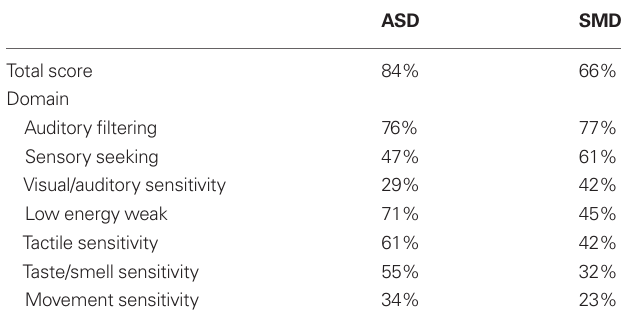
Table 1 | Percentage of groups with clinically signifi cant